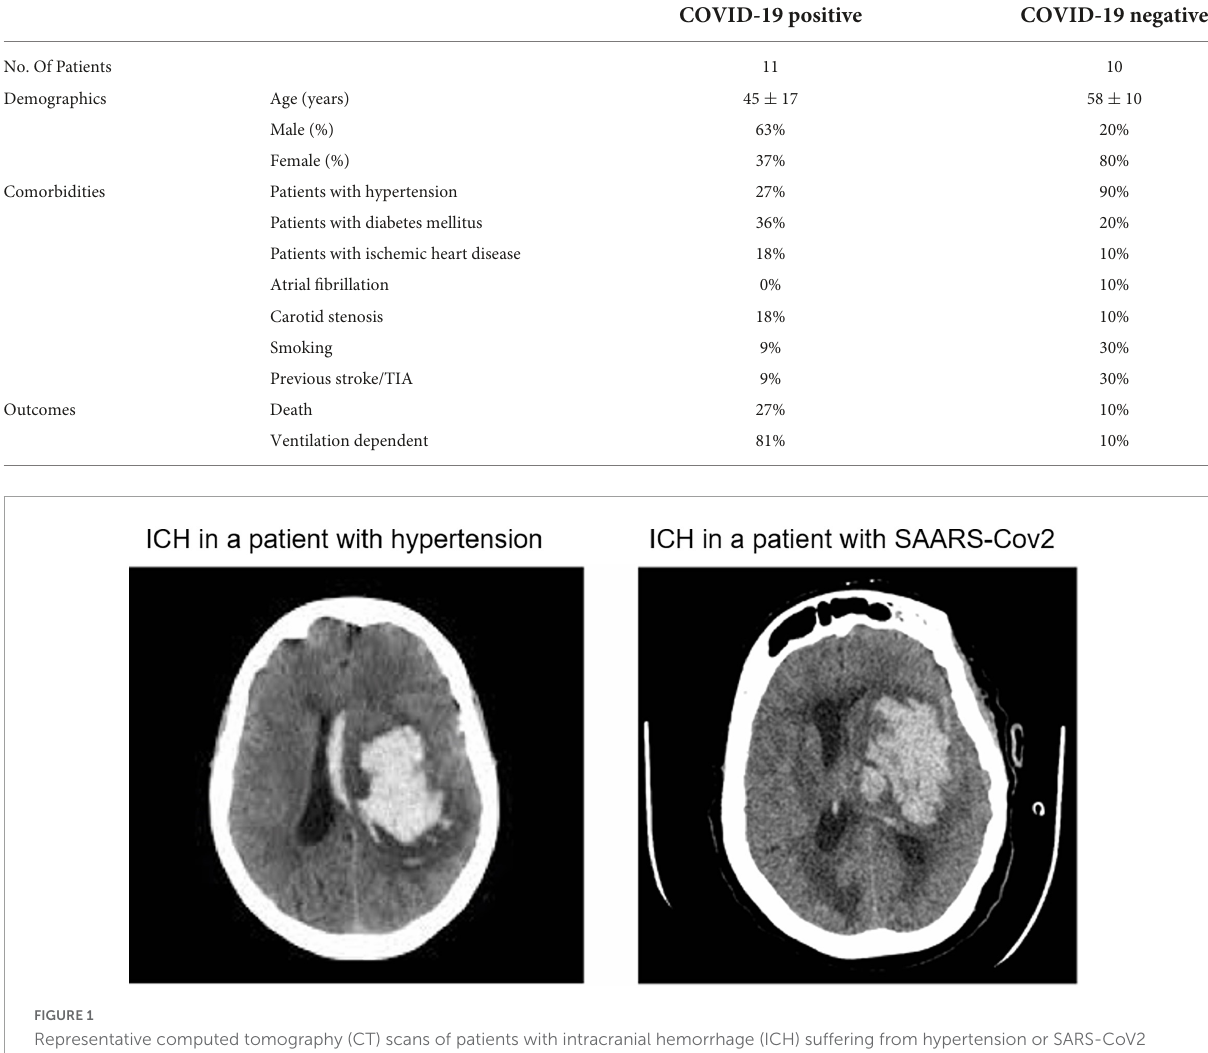
TABLE 1 Demographics, comorbidities, and outcomes.